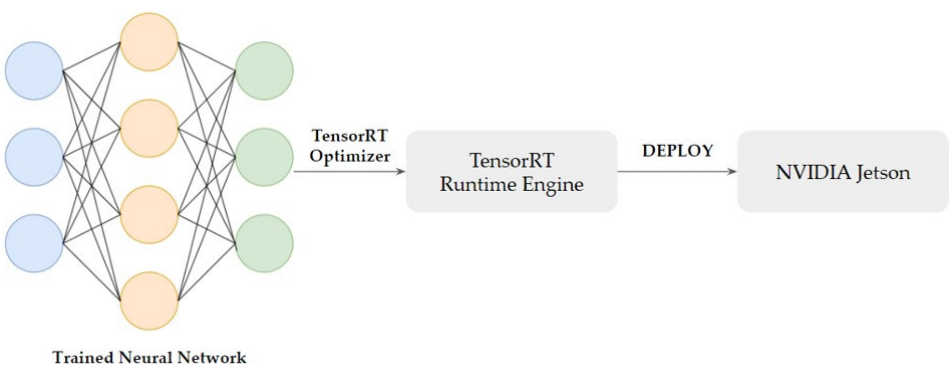
Figure 1. Deep Learning Model Deployment Workflow on NVidia Jetson Devices.